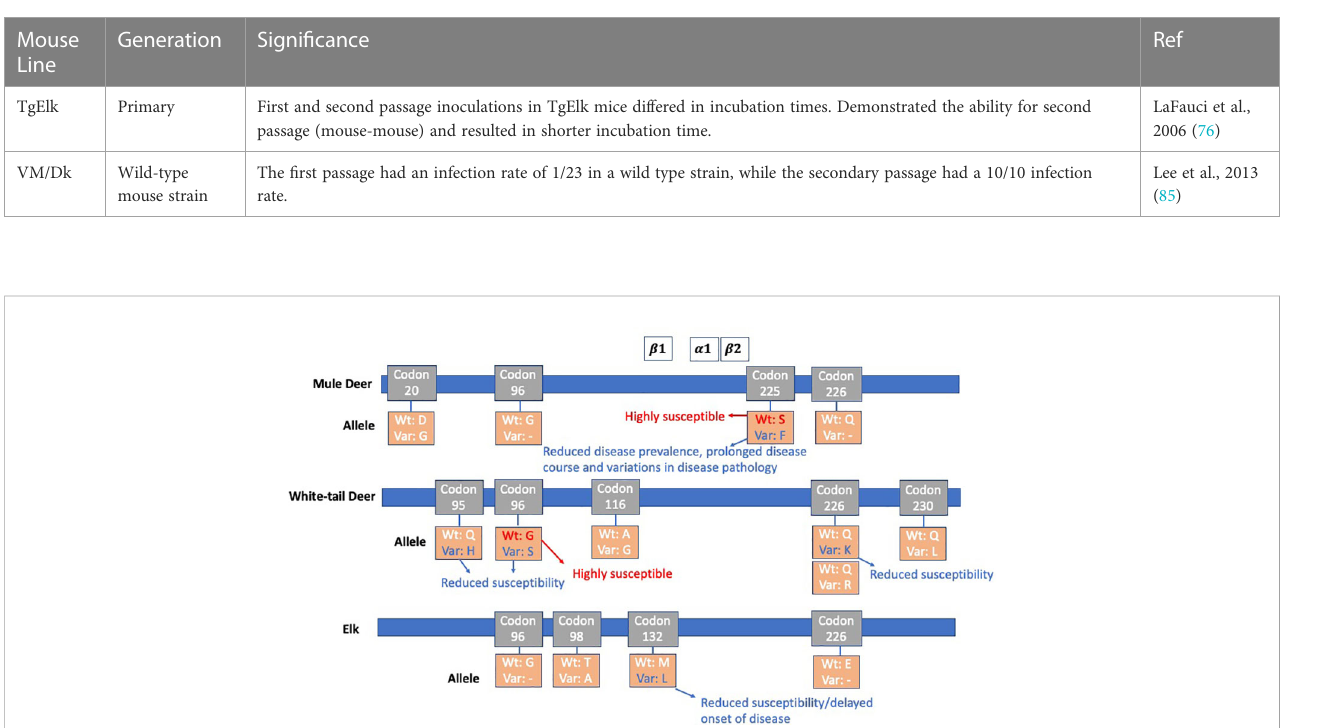
TABLE 4 Transmission by passage through